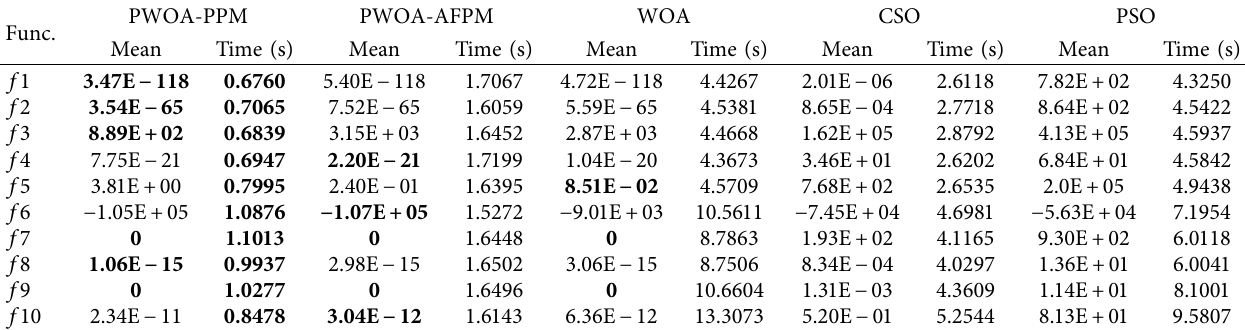
Table 4: Comparison between the proposed algorithms and the state-of-the-art algorithms (256D). Func.